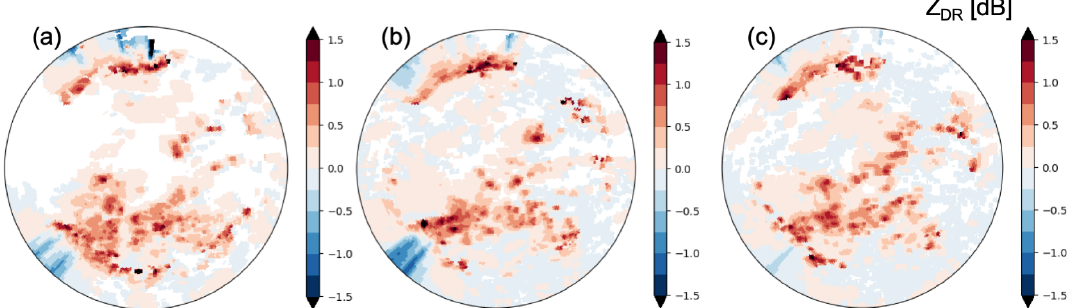
Figure 6. Synthetic PPI of Z DR at 0.5 ◦ elevation for the DWD radar site Neuheilenbach based on the analysis obtained for 4 June at 16:00UTC by assimilation of radar reflectivity and using three different ways to specify the model error: large-scale uncertainty (a) , large plus unresolved scales of uncertainty (b) , and in addition the use of the warm bubble approach (c) .